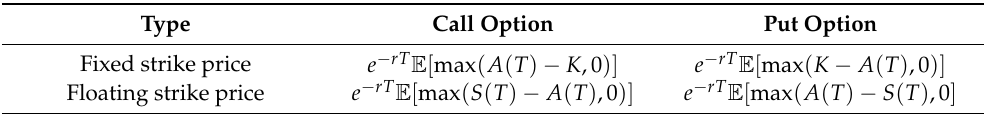
Table 2. Price of arithmetic average Asian